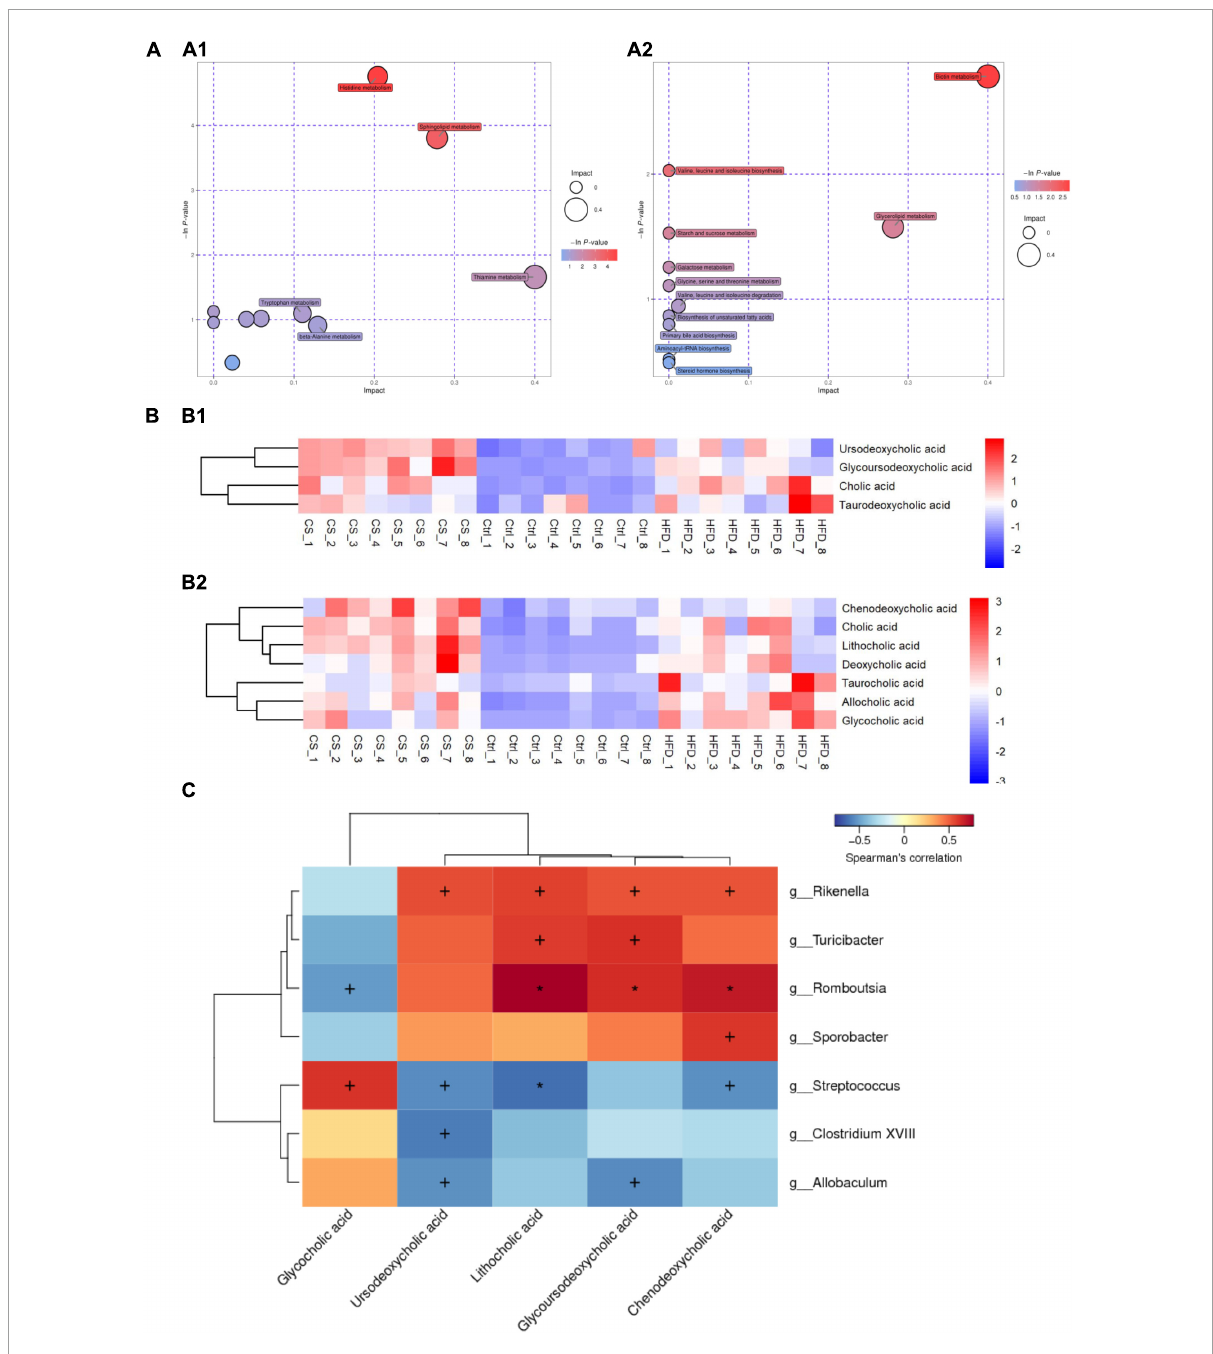
FIGURE10 CS supplementation modulates fecal metabolite pathways and profiles in HFD-fed mice. (A) Bubble plot map of metabolic pathways (A1: POS ion, A2: NEG ion); (B) heatmap of bile acids (B1: POS ion, B2: NEG ion); (C) heatmap of Spearman’s correlation between microbiota and bile acids, the correlation significant test was carried out, when p < 0.05, + was used to mark the significance, when p < 0.01, * was used to mark the significance. Control diet (Ctrl) group, high- fat diet (HFD) group, corn silk (CS)